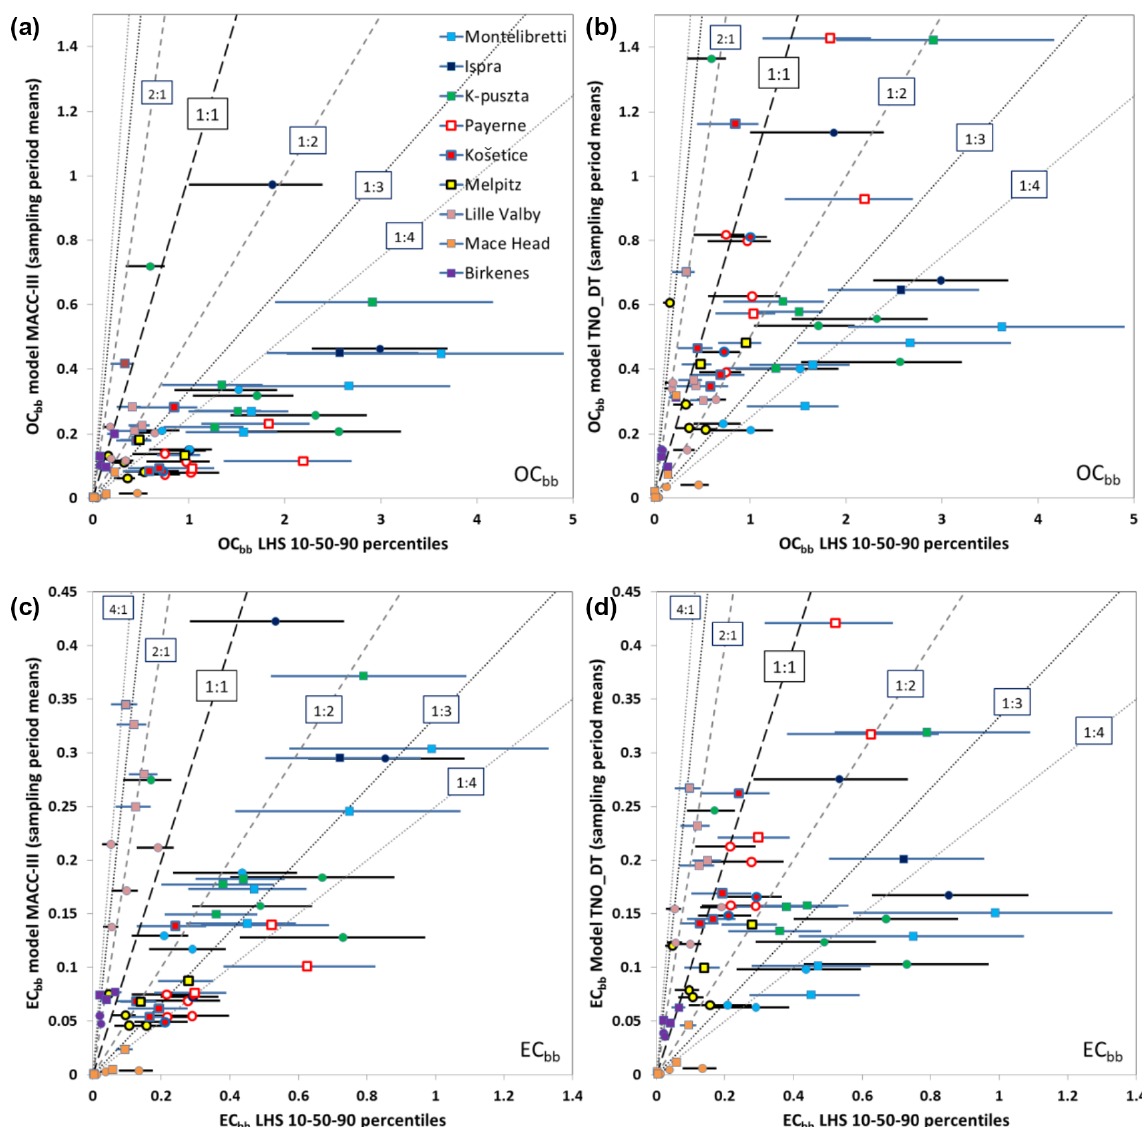
Figure 3. Comparison of modeled and measurement-/LHS-based concentrations of organic and elemental carbon from biomass burning emissions (OC bb and EC bb ). Panels (a) and (c) show model-calculated OC bb (a) and EC bb (c) with the base-case model setup, and panels (b) and (d) show the corresponding results using the DT + IVOC model setup. Each point (and horizontal line) represents the results from a single site and week. The lines illustrate the range from the LHS 10th percentile to the 90th percentile, and the circles and squares show the LHS median values. Circles and black horizontal lines show results for fall 2008, and squares and blue lines show results from winter/spring 2009. The different sites are identified as follows: light blue – Montelibretti; dark blue – Ispra; green – K-puszta; white with red border – Payerne; red with blue border – Košetice; yellow with black border – Melpitz; pink – Lille Valby; orange – Mace Head; purple – Birkenes. Units: µgCm − 3